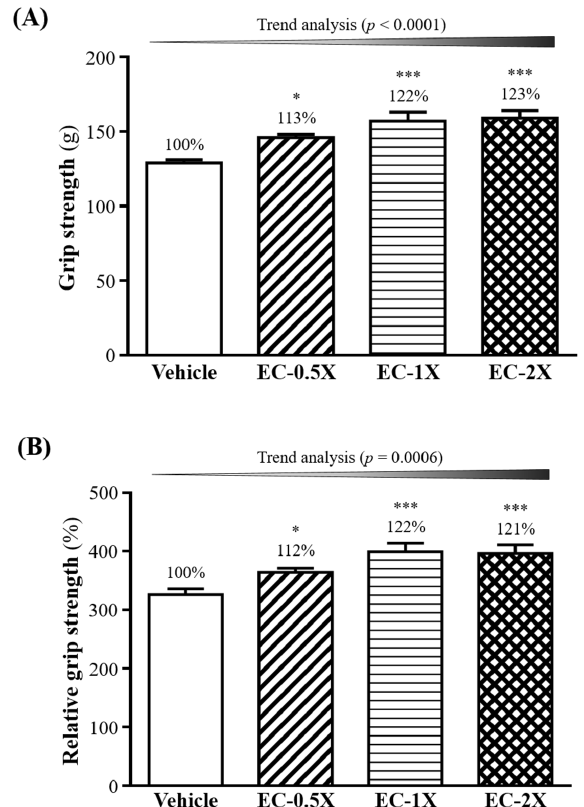
Figure 2. Effect of a four-week EC supplementation on: ( A ) forelimb grip strength and ( B ) relative forelimb grip strength in mice. Mice were pretreated with the Vehicle, EC-0.5X, EC-1X, and EC-2X for 28 days. Data is expressed as mean ± SEM ( n = 10). Numbers indicate percentage (%) change with vehicle group fixed at 100%. Significant difference from control group according to one-way ANOVA is indicated * p < 0.05, *** p <